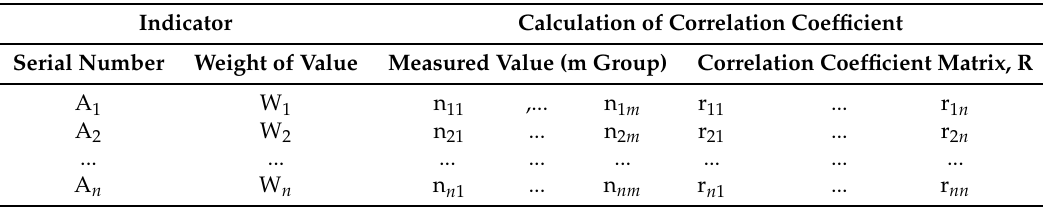
Table 2. The input parameters of comprehensive weight.